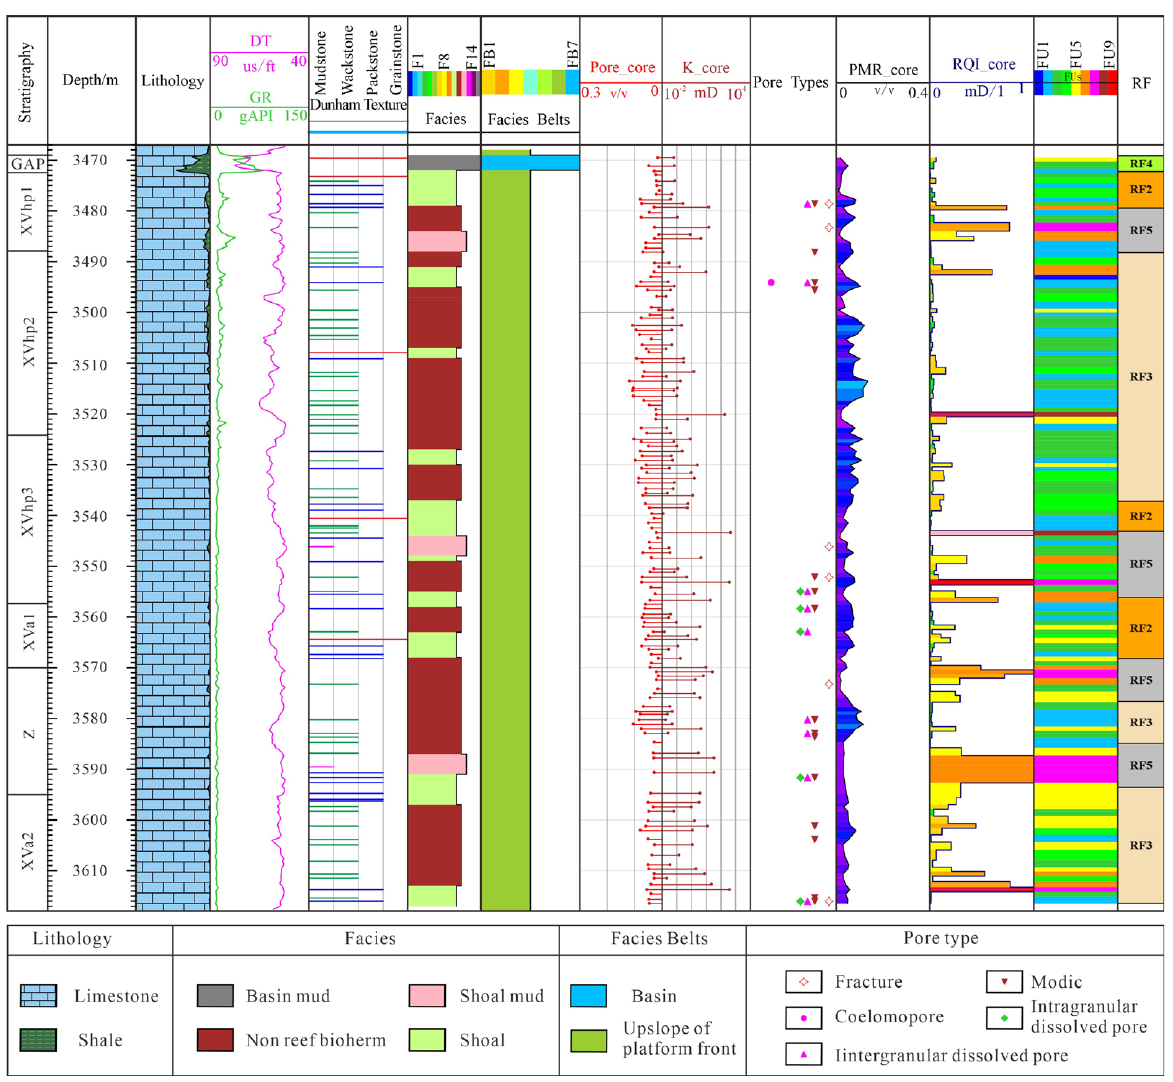
Figure 12. Correlation between different parameters including depositional, diagenetic, porosity, permeability, and flow units in the Callovian-Oxfordian stage of well C1.